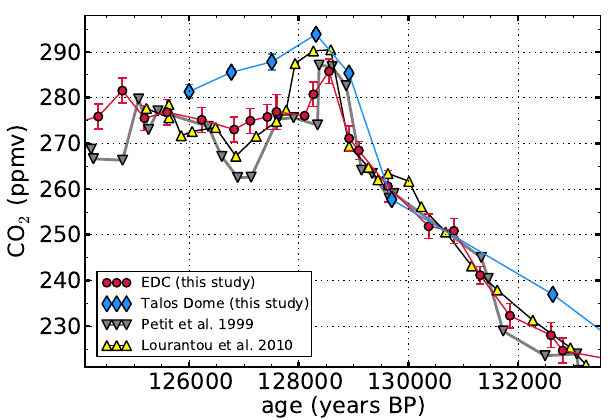
Fig. 3. CO 2 as in Fig. 1 but zoomed to 132500 to 124000 years BP: CO 2 (red circles) measurements on EDC (EDC3 age scale) and on the Talos Dome (blue diamonds) ice cores (TALDICE-1a age scale) from this study are shown next to CO 2 data previously measured by Petit et al. (1999) (grey downward pointing triangles) on the Vostok ice core and the reconstructions from Lourantou et al. (2010b) (yellow, upward pointing triangles) on EDC.